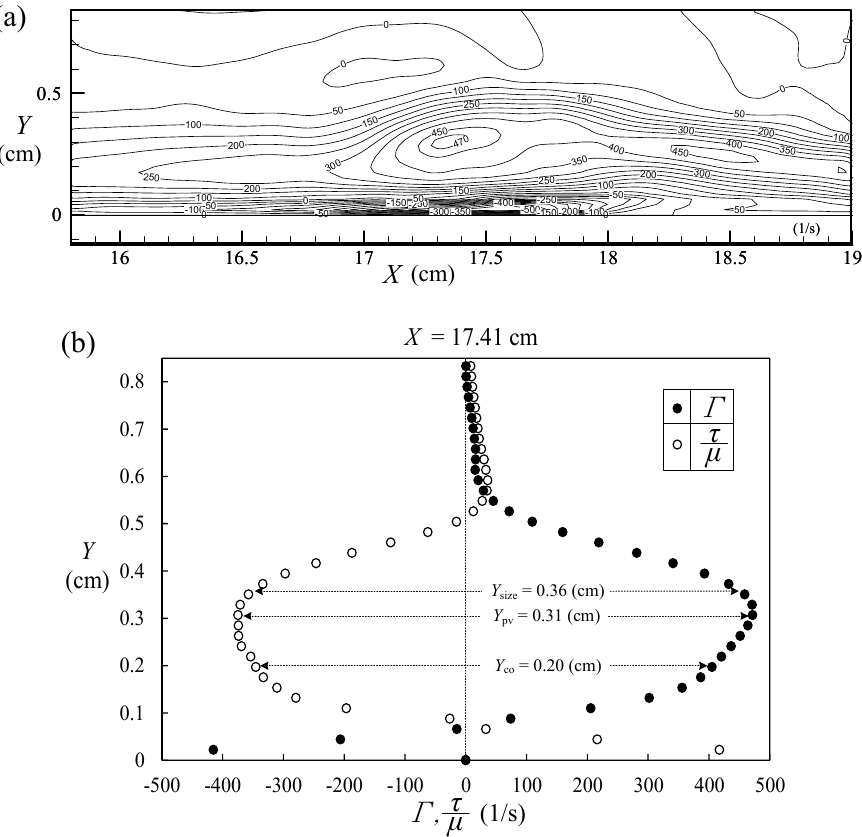
Figure 14. ( a ) Distribution of the vorticity contour, Г ( X , Y ), around the primary vortex (unit in 1/s); ( b ) distributions of both the vorticity, Г ( Y ) and the shear stress divided by the dynamic viscosity, τ ( Y )/ μ , at X co = 17.41 cm for t = 1.0068 s.